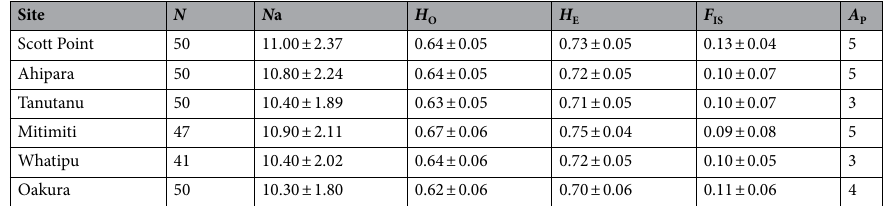
Table 1. Descriptive measures of genetic variation in Perna canaliculus for 10 microsatellite loci and six site samples. Number of mussels ( N ), mean number of alleles per site ( N a), observed heterozygosity ( H O ), expected heterozygosity ( H E ), the fixation index ( F IS ) and the number of private alleles across all loci ( A P ). Sites are arranged north to south. N = number of mussels analysed; Na = number of alleles per locus (mean ± SD); H O = observed heterozygosity; H E = expected heterozygosity; F IS = fixation index; A P = total number of private alleles.